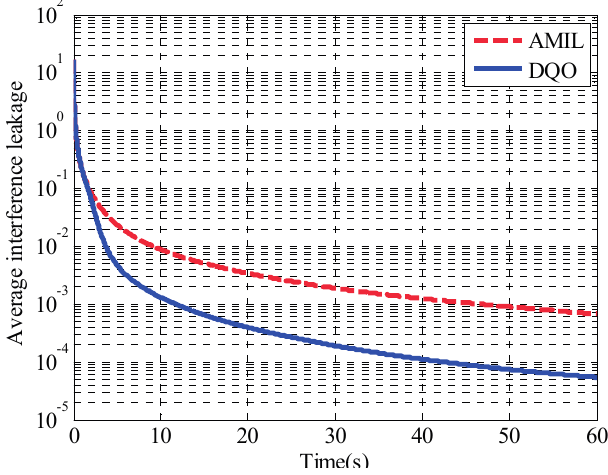
Figure 9. Convergence curves of the average interference leakage in (10 × 10, 1) 19 .